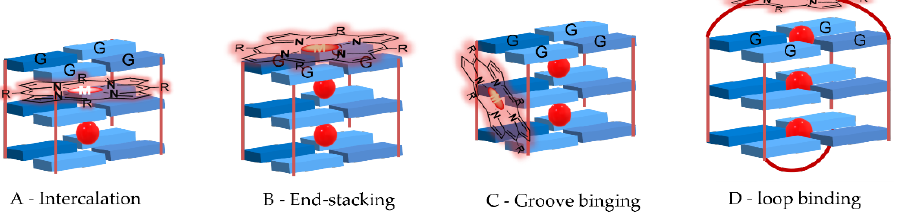
Figure 7. ( A – D ) Types of interactions ligand-G-quadruplexes. For simplicity, grooves are not represented. Simple procedures using optical spectroscopic techniques like ultraviolet-visible ab- sorption (UV-Vis), fluorescence and circular dichroism (CD) allow to evaluate the ligand affinity and selectivity to DNA structures, while other spectroscopic methods such as mass spectrometry (MS) and nuclear magnetic resonance (NMR) allow to obtain kinetic, thermodynamic, stoichiometric and conformational data in structure-activity relationship (SAR) studies [31,32,41–43]. The efficiency of several small molecules to inhibit telomerase by adduct formation with GQs has been studied using different methods with promising results [30,31,44–48]. Under the context of aromatic ligands containing fused rings, the dicationic anthra- quinone derivative presented in Figure 8 was the first ligand reported to inhibit telomer- ase function [38]. Many other small ligands were then reported to inhibit telomerase ac- tivity with small half-maximal inhibitory concentration (IC 50 ) values, like tri-substituted acridines (e.g., BRACO-19) [49], the perylene tetracarboxylic diimide derivative (PIPER) [50], the fluorinated polycyclic quinoacridinium cation (RHPS4) (Figure 8) and dibenzo- phenanthroline derivatives [51], among others [12,39,52]. Amongst the aromatic macrocycles, porphyrins, such as the cationic H 2 TMPyP and analogs appear as the most widely tested telomerase inhibitors [32,33,53–55].